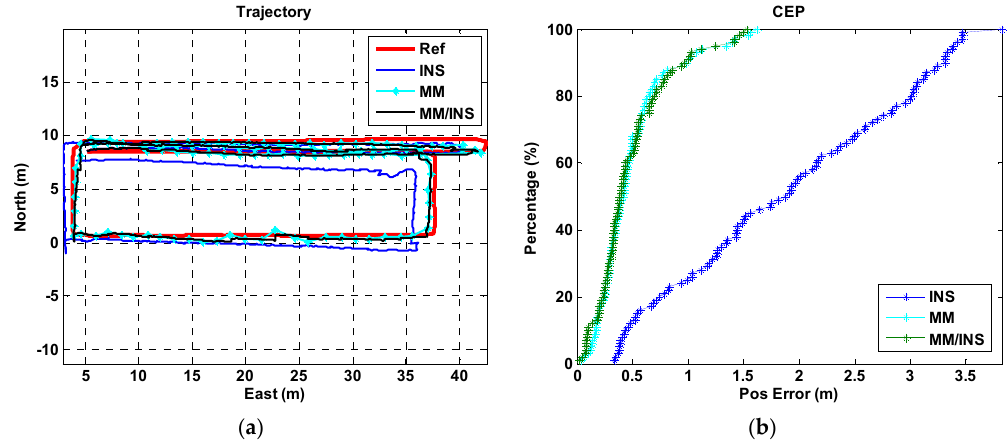
Figure 10. Navigation results of the INS, MM, and MM/INS solutions in building A. (Test II: Pedestrian II, Trajectory I, Huawei P10). ( a ) Trajectories; ( b ) cumulative error percentages.